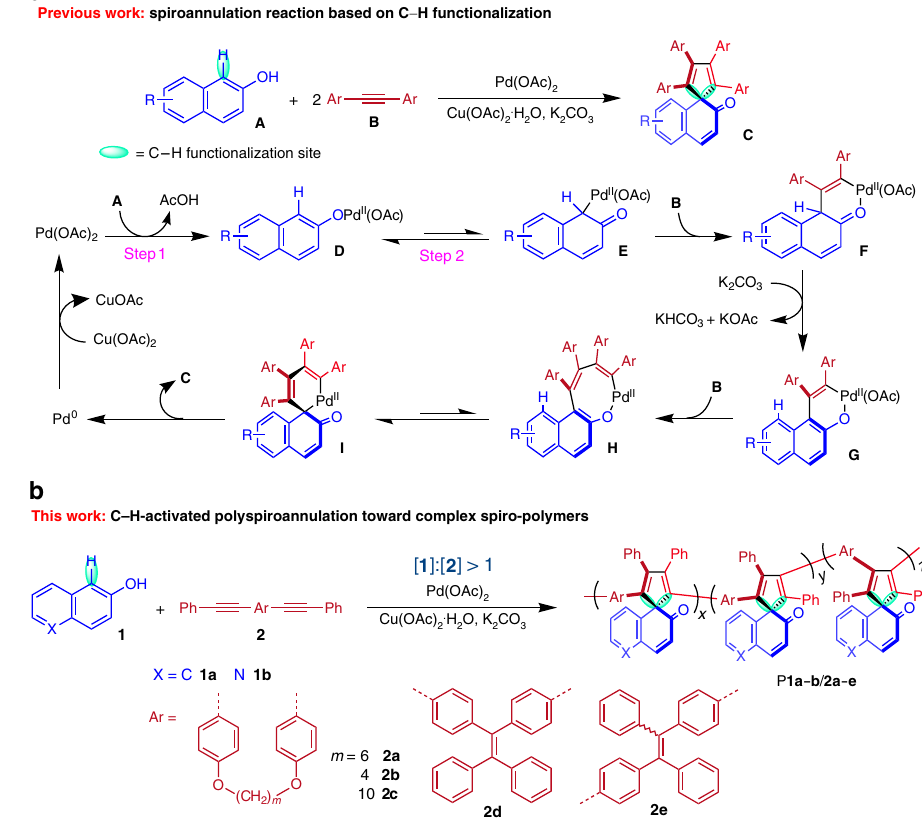
Fig. 1 Developing the spiroannulation reaction into a polyspiroannulation strategy. a Palladium(II)-catalyzed oxidative spiroannulations of naphthols and diarylacetylenes and the associated mechanism. b Palladium(II)-catalyzed polyspiroannulations of free naphthols and internal diynes for the construction of complex spiro-polymers in this work. [ 1 ]:[ 2 ] = molar feed ratio of monomer 1 and 2